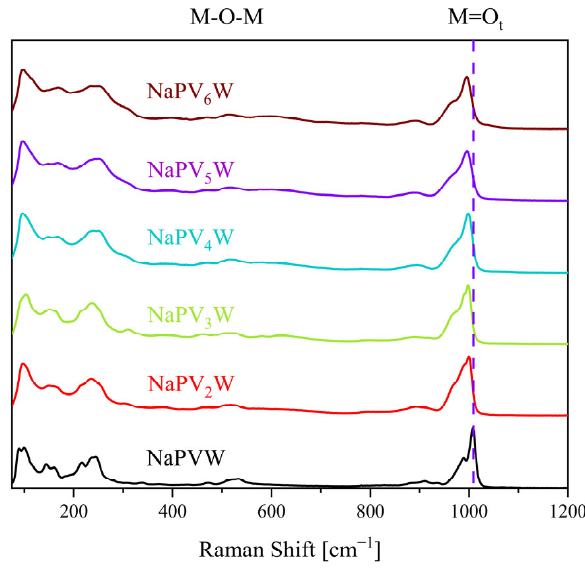
Figure 3. Raman spectra of the POMs NaPV x W, with x = 1 to 6. The purple line runs through the peak maximum of an M = O t vibration band from NaPVW, to illustrate the trend of the peak shift dependence on the substitution degree.